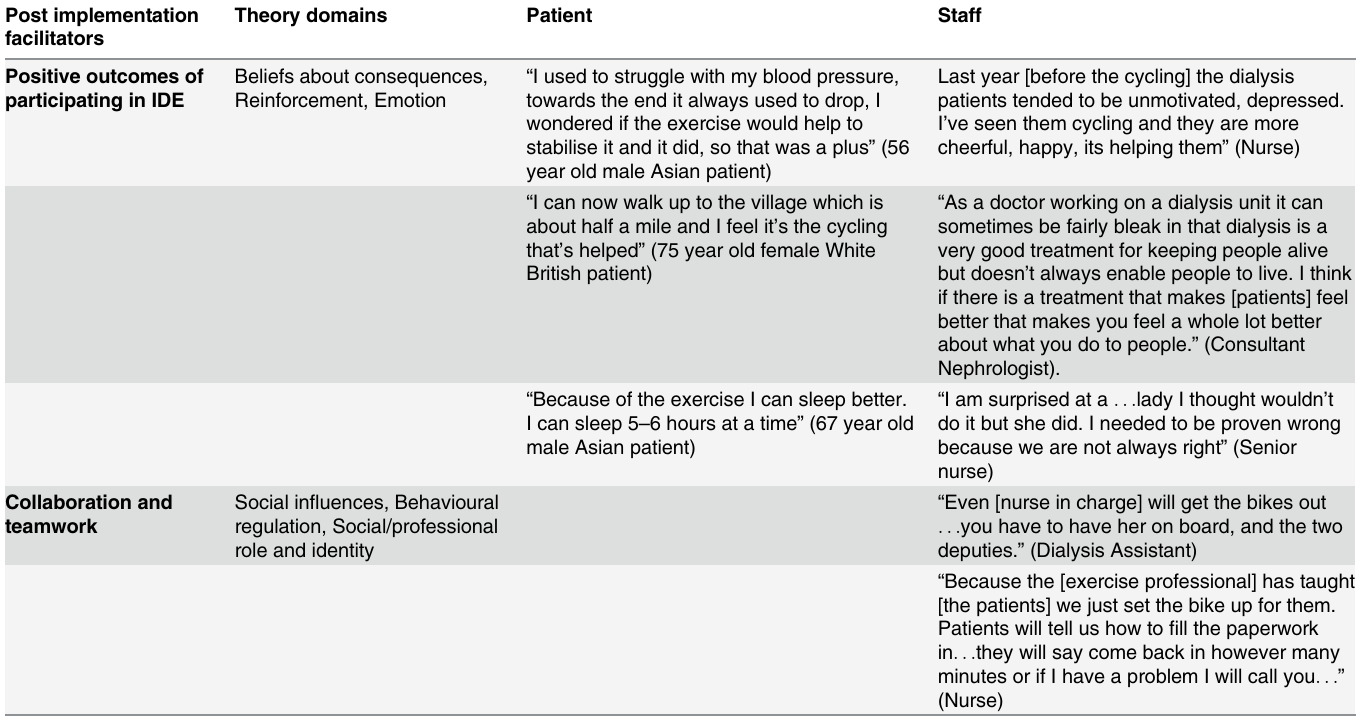
Table 5. Facilitators to IDE post-implementation, as identified by patients and